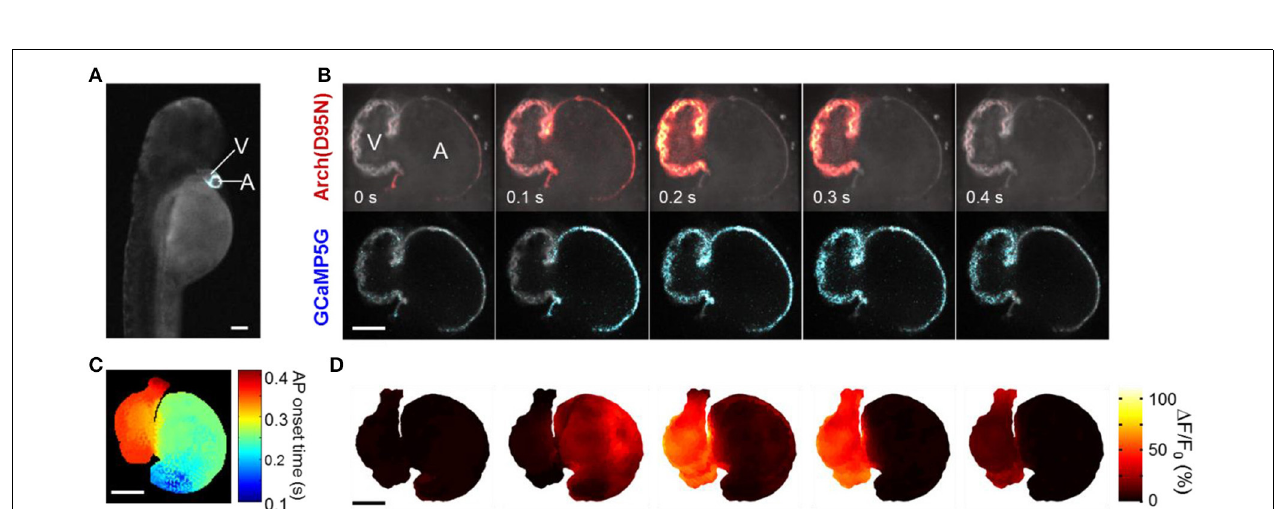
measured in an epifluorescence microscope with laser excitation and an imaging spectrometer. The wavelength range of the excitation spectra of Arch(D95N) was limited by available laser lines. The blue (488nm) light used to excite GCaMP5G induced negligible spurious excitation of Arch(D95N), a consequence of the vastly higher illumination intensity needed to excite Arch(D95N) than to excite GCaMP5G. In Arch(D95N), the voltage-sensitivity spectrum (dF/dV) is slightly red-shifted relative to the fluorescence excitation spectrum. (E) Optical section of zebrafish heart expressing CaViar, showing localization of the reporter to cell membranes.